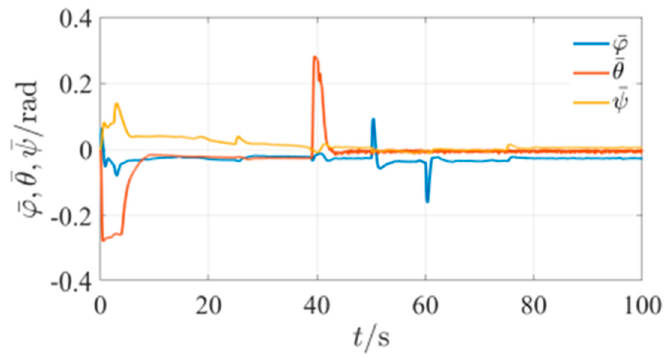
Figure 40. Attitude of the mobile platform during landing process.